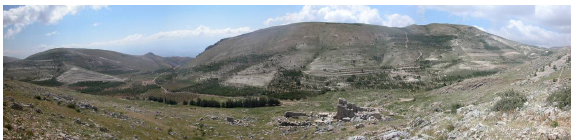
Figure 2. The valley under Hosn-Niha sanctuary and village © J. Yasmine; May 2005.